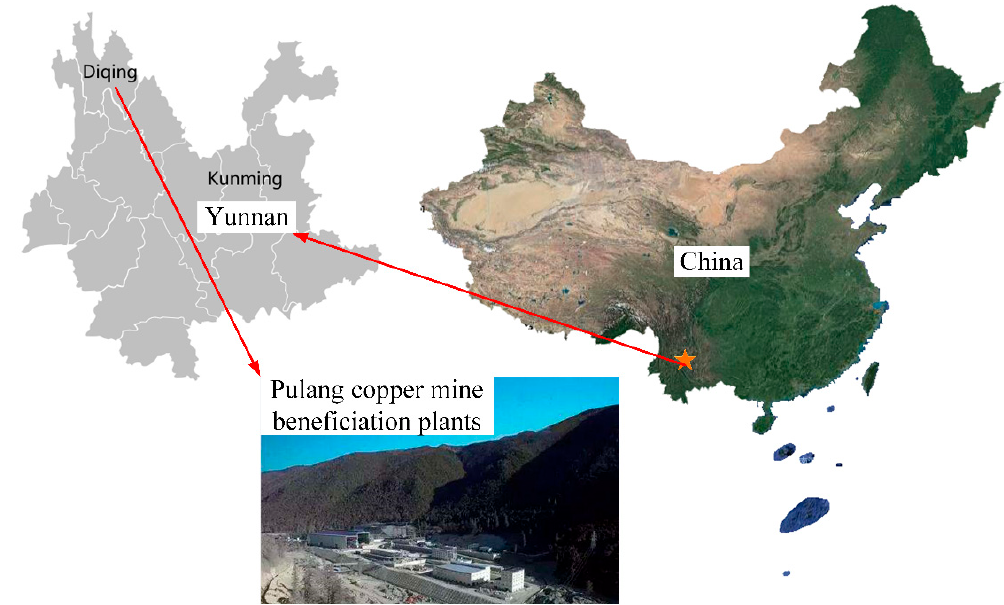
Figure 4. Location of the Pulang copper mine.